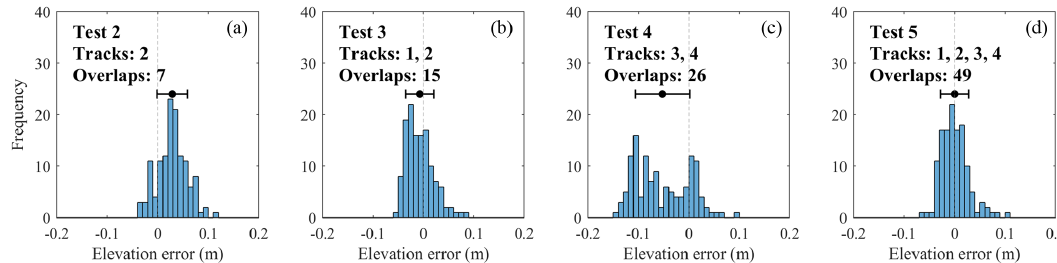
Figure 6. Elevation error distribution for tests 2, 3, 4, and 5. Ordinates indicate number of GPS points in each bin.